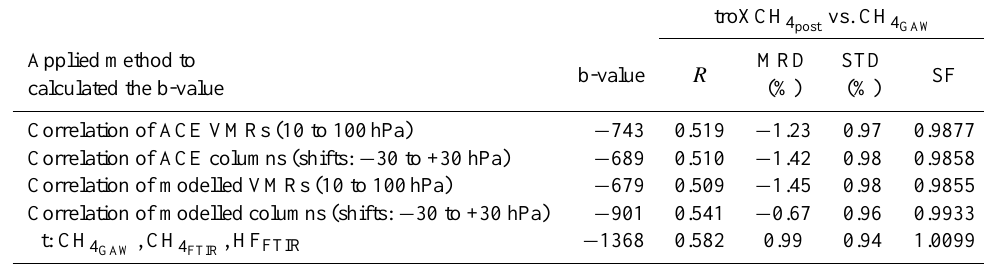
from profiling retrieval. col